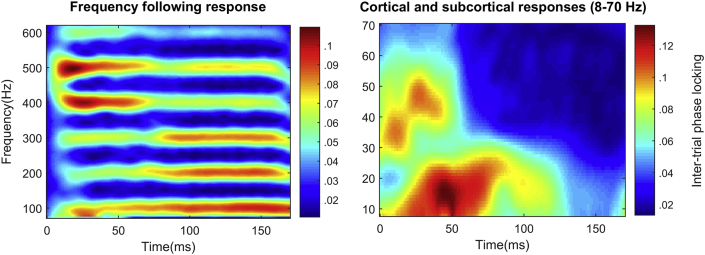
(Left) Time–frequency plot of inter-trial phase locking across all subjects for the frequency following response (71–600 Hz). (Right) Time–frequency plot of inter-trial phase locking across all subjects for the cortical response (8–70 Hz).